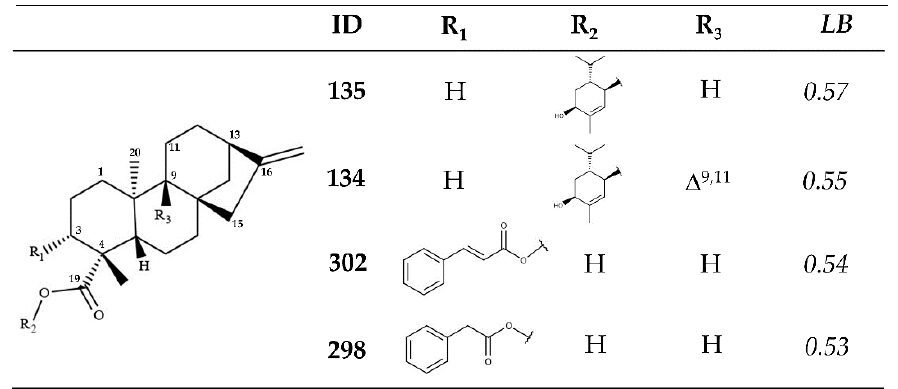
Figure 1. Potentially active kauranes, identified using RF model (ligand-based VS), for L. major . LB active probability value.